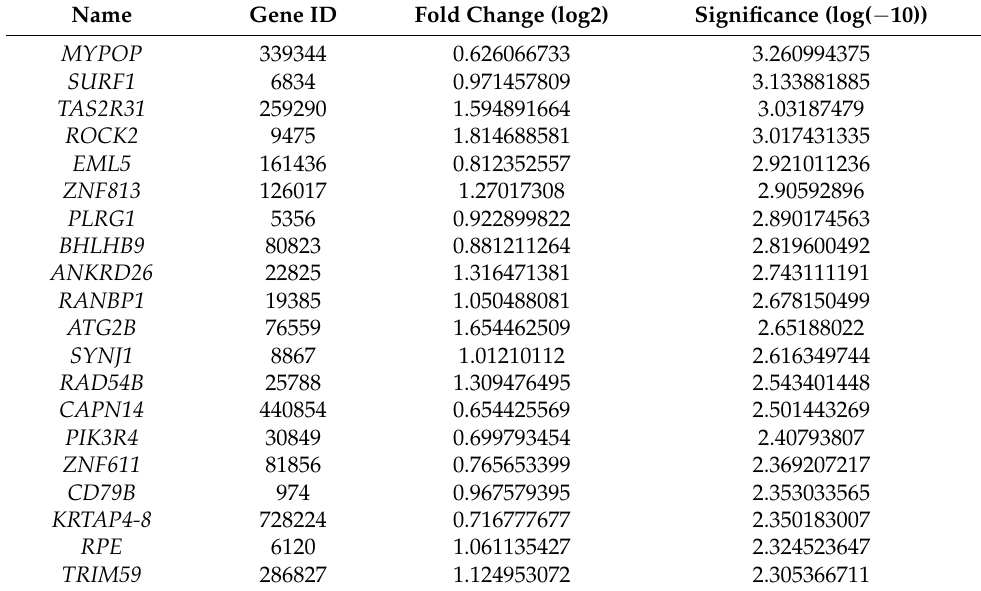
Table 3. Top 20 genes upregulated in OR vs. WT PC cell lines.